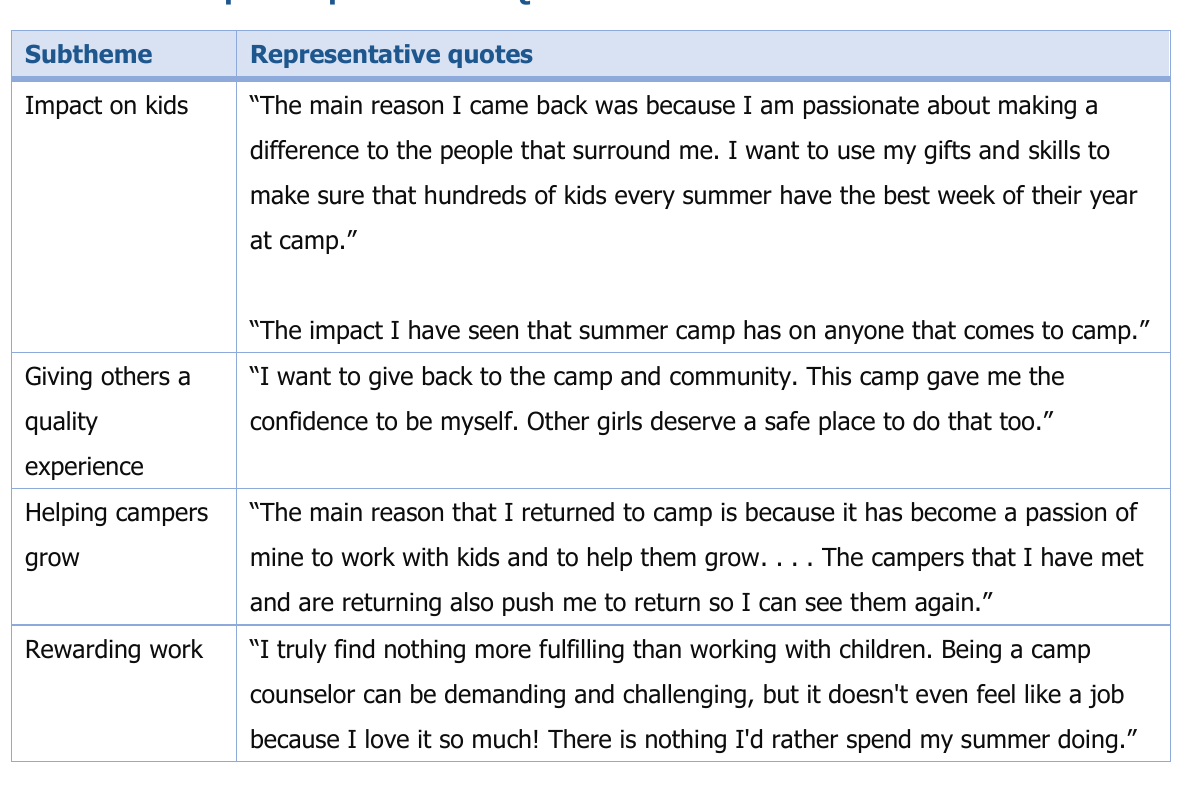
Table 5. Job Impact Representative